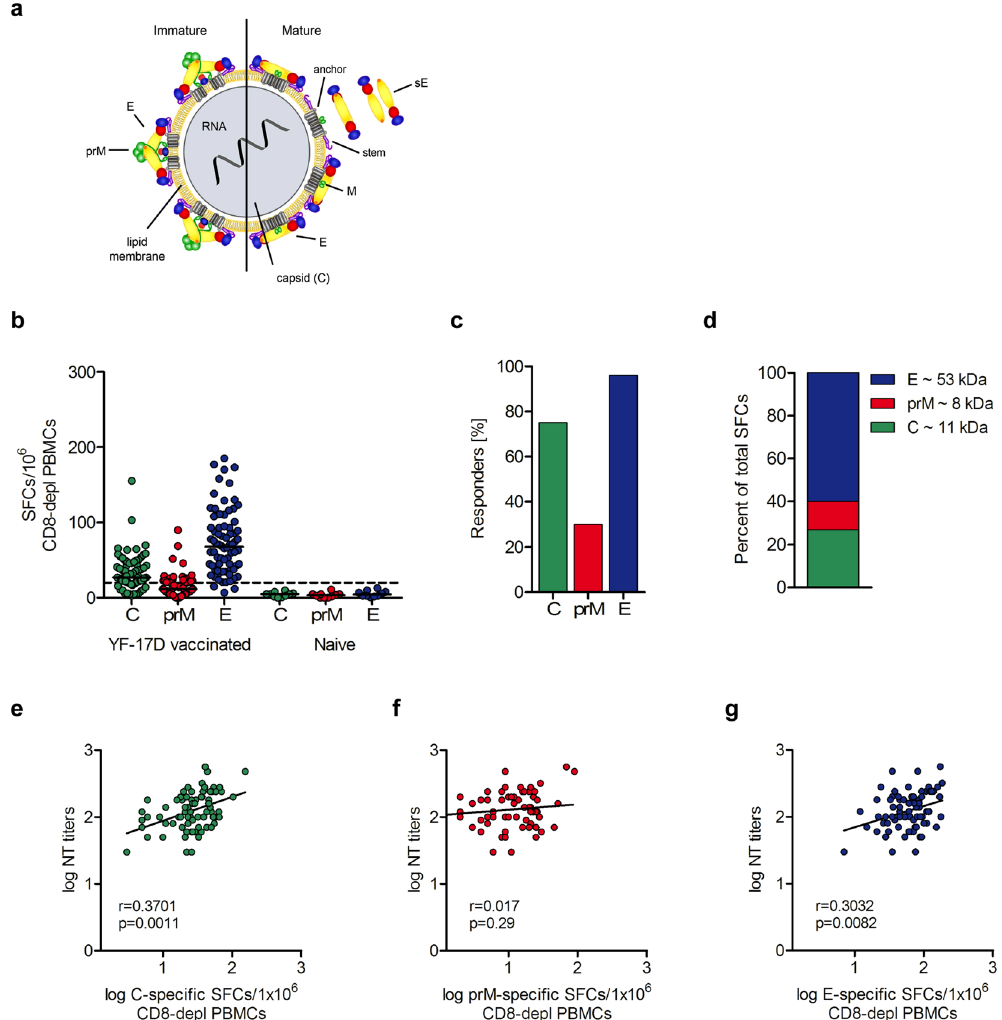
Figure 1. CD4 T cell and neutralizing antibody response to YF-17D vaccination. ( a ) Schematic representation of immature and mature flavivirus particles. The virion contains three structural proteins: C (capsid), prM (membrane) and E (envelope). The envelope of immature virions is covered by spikes of prM-E heterodimers. In mature virus particles, E proteins are arranged into homodimers. The soluble form of E (sE) lacks the membrane anchor and stem region. Reproduced from Vratskikh, et al . 68 . ( b ) Individual CD4 T cell responses to YF virus C, prM and E from 76 YF-vaccinated and 10 YF-naïve individuals as determined in IL-2 ELISPOT assays. Results are given as spot forming cells (SFCs). Medians are depicted as black lines. The dashed line represents the cut- off for assay positivity. ( c ) Responder frequencies to C, prM and E in 76 YF vacinees. ( d ) Percentage of spots contributed by C, prM and E peptides in 76 YF-17D vaccinees. ( e – g ) Spearman correlation of C- prM- and E-specific CD4 T cell responses and neutralizing Ab titers. Linear regressions are indicated by black